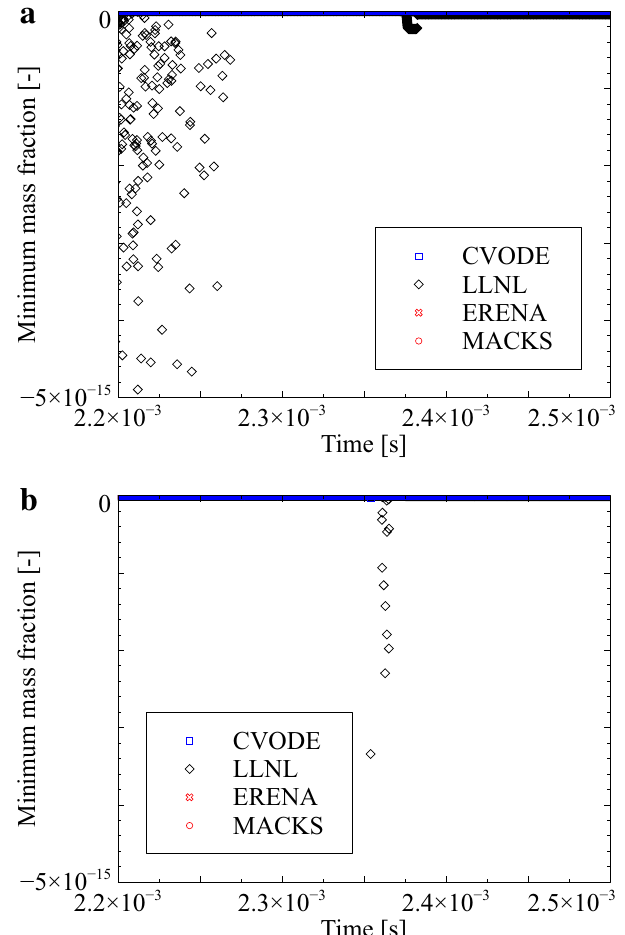
Figure 6. Time histories of the minimum mass fraction with CVODE, LLNL, ERENA, and MACKS for a CH 4 / 8 7 s air mixture with h = 1 × 10 − and 1 × 10 − , p 0 = 1.0MPa , and T 0 = 1300K